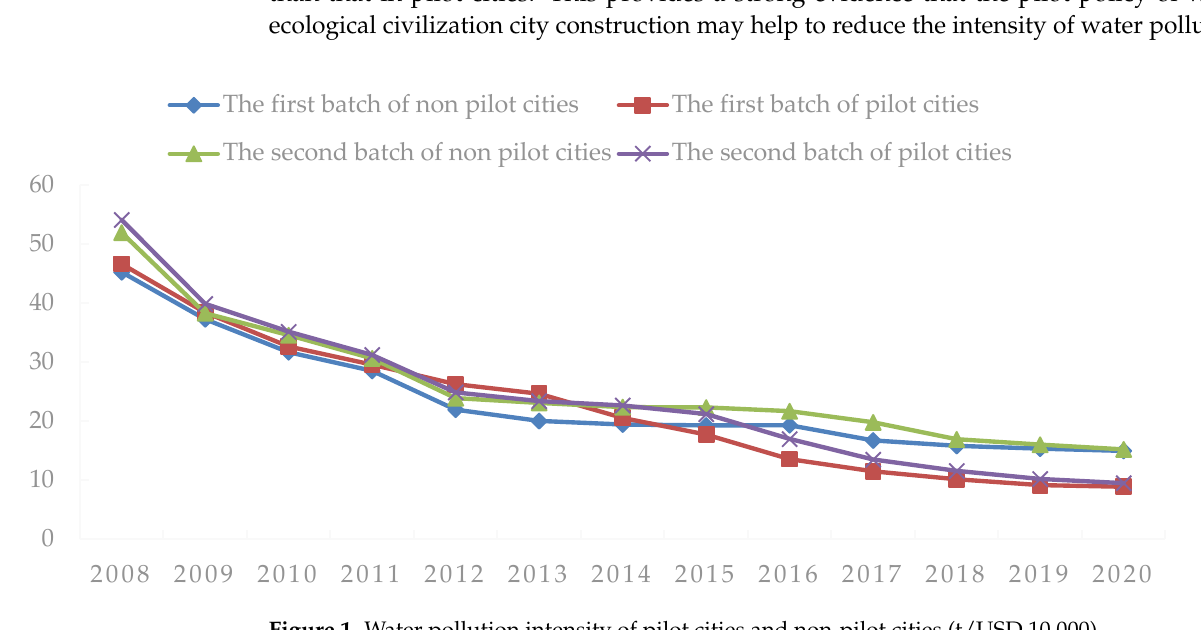
Figure 1. Water pollution intensity of pilot cities and non-pilot cities (t/USD 10,000).